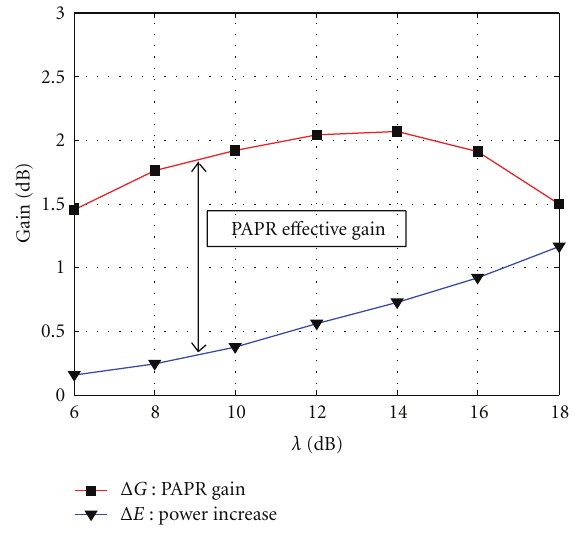
Figure 13: PAPR e ff ective gain.